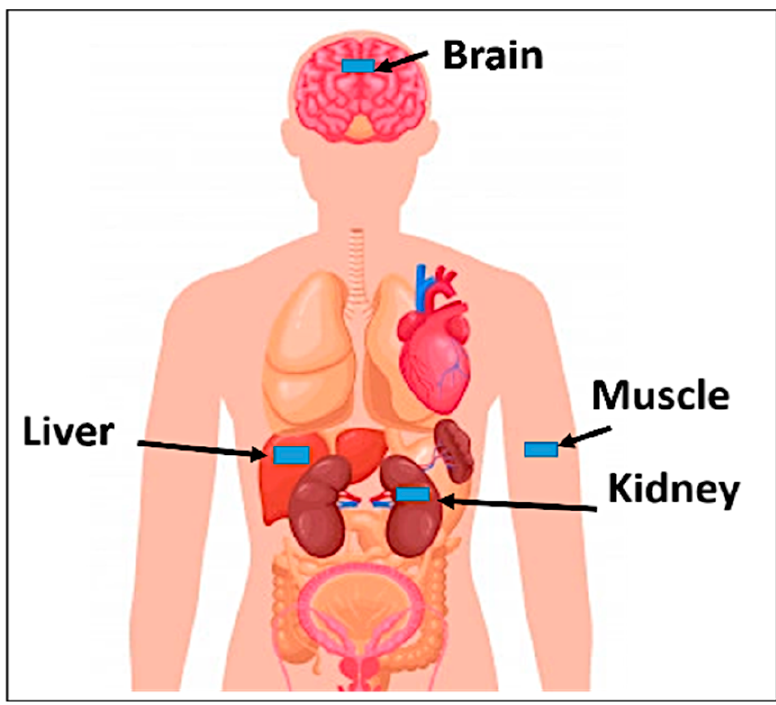
Figure 10. Distribution of areas where the antenna was implanted to be tested.